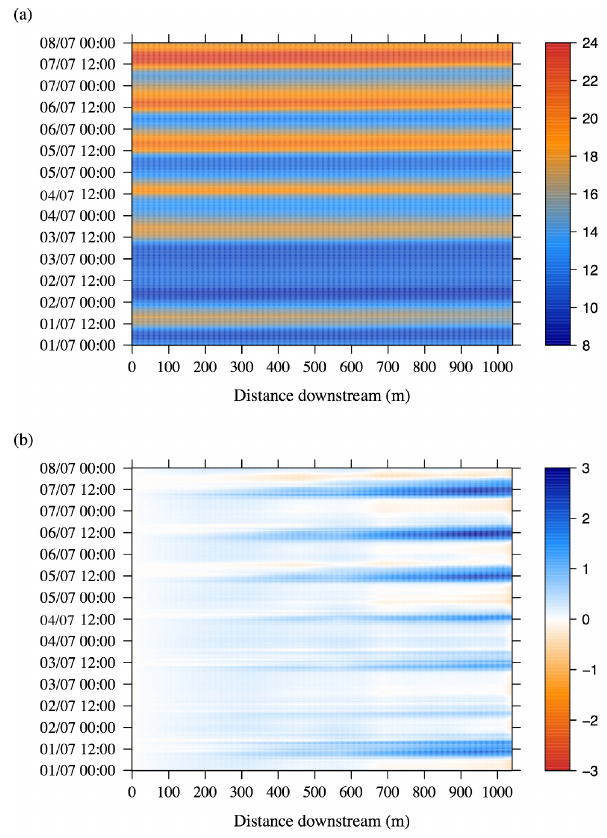
Figure 4. Spatio-temporal patterns in instantaneous water temper- ature measurements: (a) absolute values ( ◦ C) and (b) differences between AWS Open and each monitoring location within the reach (positive values indicate instantaneous cooling gradients). Values for both panels were interpolated linearly at 1m intervals from ob-